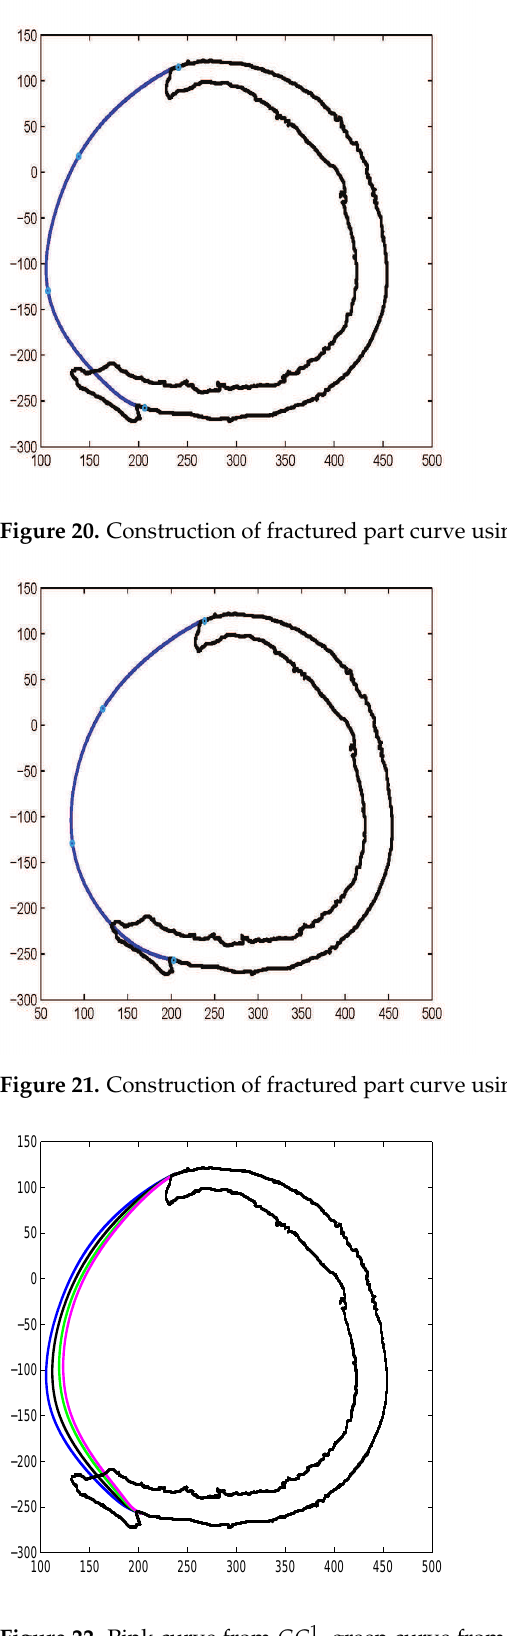
Figure 22. Pink curve from GC 1 , green curve from GC 2 , black curve from B-spline and blue curve from NURBS